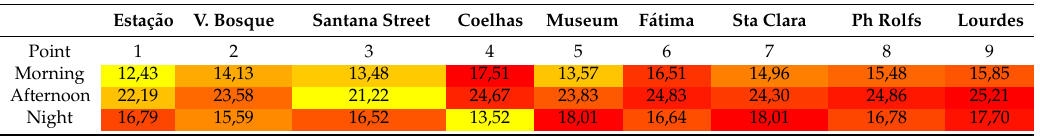
Table 4. Average temperature ( ◦ C) at the collection points in the municipality of Viçosa-MG in the period between 3 and10 May